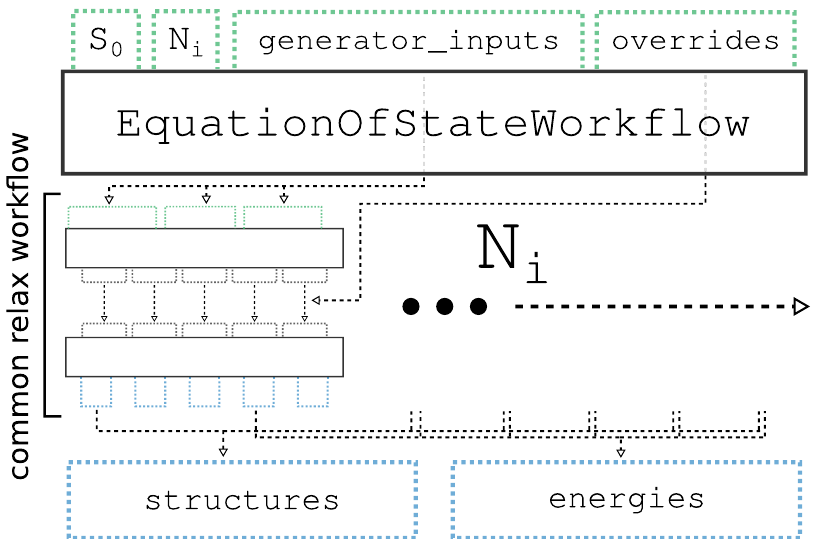
Fig. 6 Schematic diagram of the code-agnostic EOS work fl ow. Schematic diagram of the implementation of the code-agnostic EquationOfStateWork fl ow . The EquationOfStateWork fl ow takes a number of arguments: S 0 is the structure of the system at equilibrium volume and N i are the number of volumes for which to compute the total energy. The generator_inputs will be passed directly to the inputs generator of the chosen common relax work fl ow implementation, which is called N i times, once for each system volume. Note that the inset marked as “ common relax work fl ow ” corresponds directly to the schematic of the common relax work fl ow in Fig. 3. This highlights that the EquationOfStateWork fl ow directly reuses the common relax work fl ow as its main building block. Which implementation of the common relax work fl ow is to be used is communicated to the EquationOfStateWork fl ow by a single input, which is not shown for clarity. The overrides port allows an expert user to override certain inputs that are automatically determined by the generator, thus making the EquationOfStateWork fl ow optionally transparent.